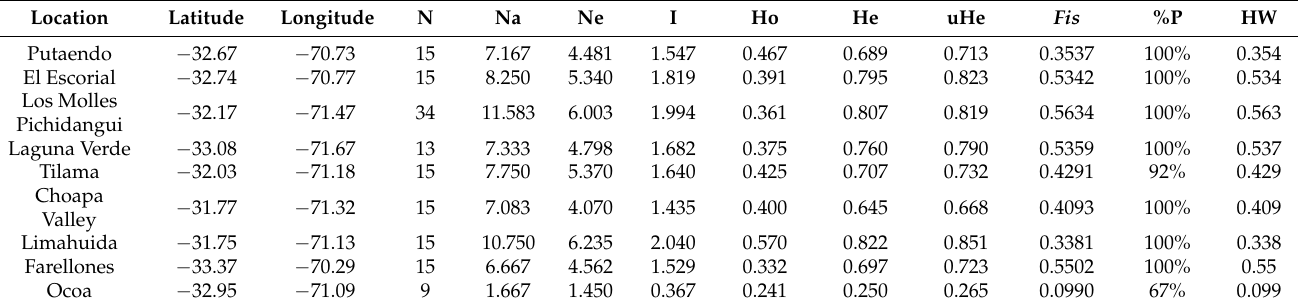
Table 2. Genetic estimators for populations of the Eriosyce curvispina complex.